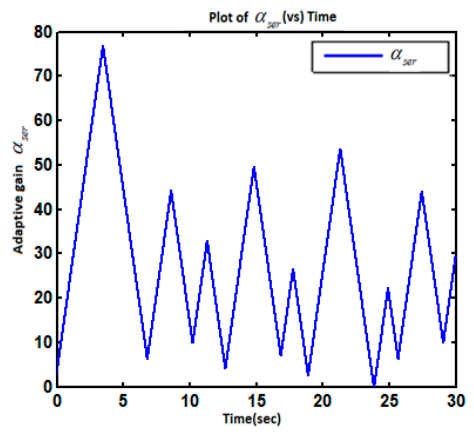
Energies 2020 , 13 , x FOR PEER REVIEW Figure 12. Plot of the adaptive gain . Figure 12. Plot of the adaptive gain α ser .